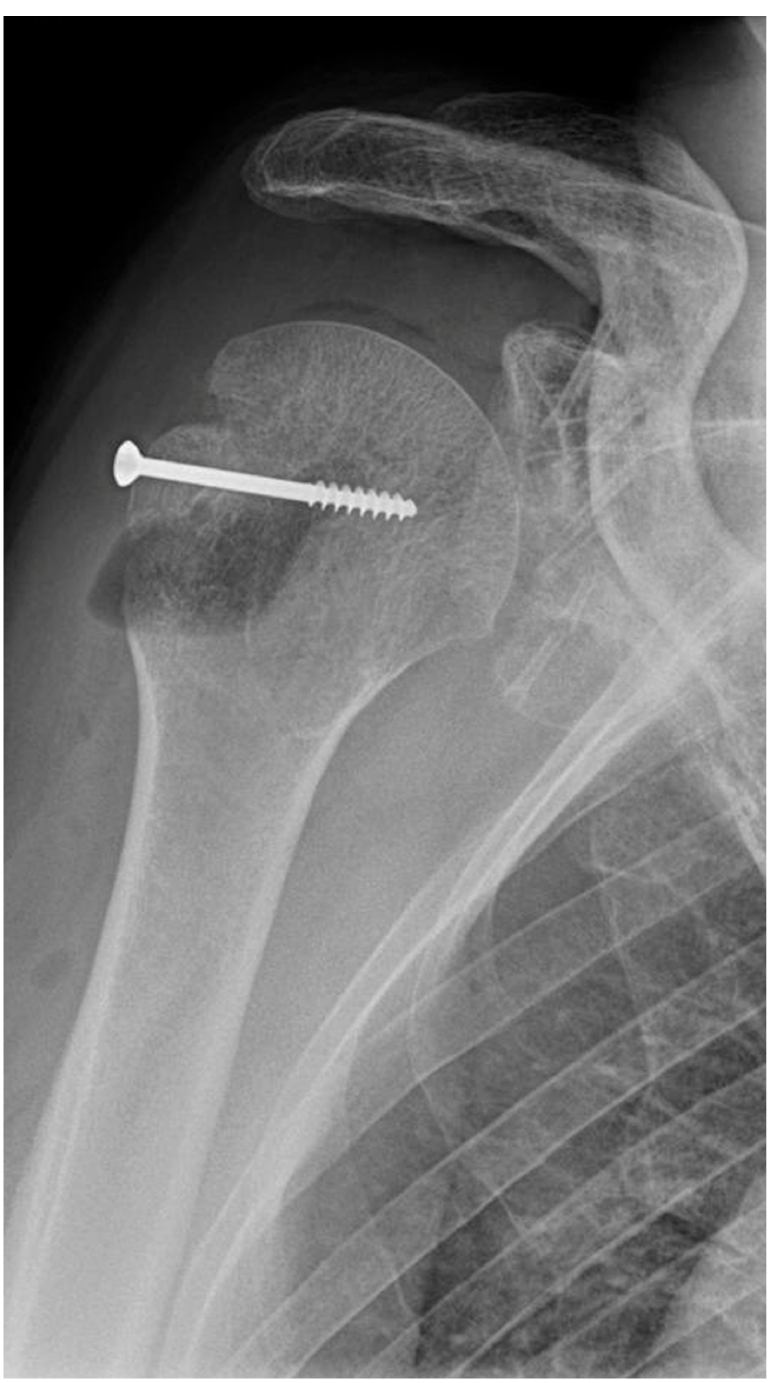
Figure 3. Material failure of MAGNEZIX ® CS screws used for osteosynthesis in a glenoid fracture after anterior shoulder dislocation.